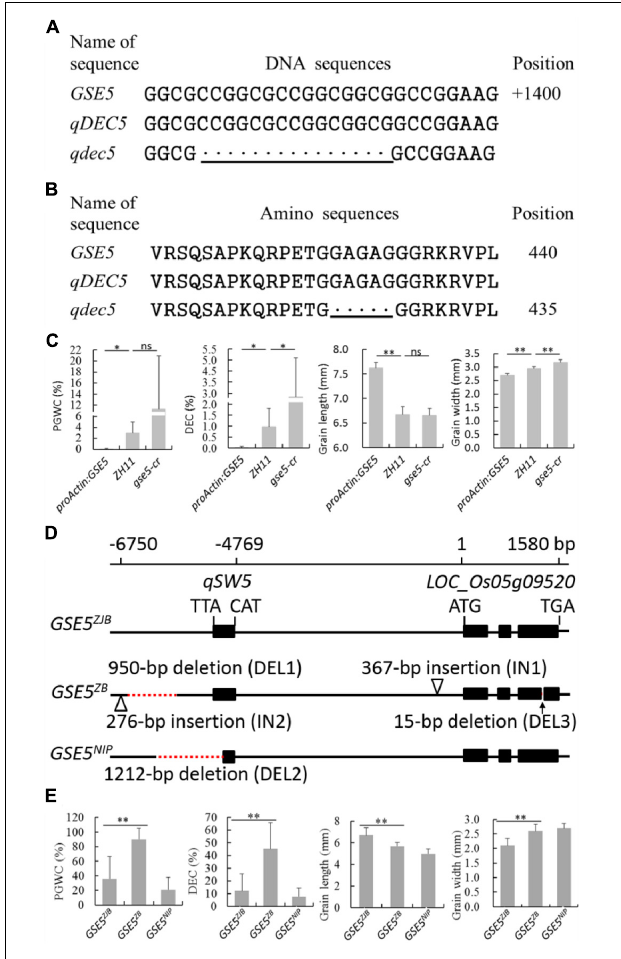
FIGURE 3 | Genotyping and phenotyping analysis of the GSE5 . (A) DNA sequence alignment of qDEC5 between ZB and ZJB. (B) Amino sequence alignment of qDEC5 between ZB and ZJB. (C) Phenotyping analysis of ZH11, proActin:GSE5 and gse5-cr . (D) The three major haplotypes of GSE5 ( GSE5 ZJB , GSE5 ZB , and GSE5 NIP ). ZJB, ZB, and NIP are Zhenjia B, Zhenshan 97B, and Nipponbare, respectively. (E) The phenotyping analysis of the rice varieties with different haplotypes. The bottom line shows the mutations. Every black “.” indicates a one-base or one-amino acid deletion. Significance is determined using analysis of variance (ANOVA) ( ∗ P < 0.05, ∗∗ P < 0.01, and ns represents no signification). The red dashed lines represent deletions, and the triangles represent insertions in the genomic